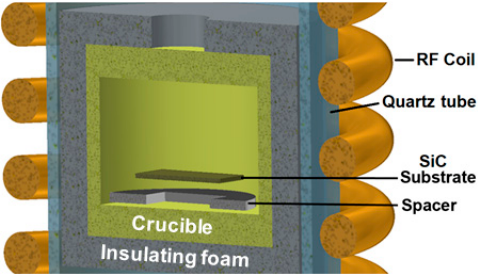
Figure 13. Sketch of a vertical RF-heated furnace in cross-section.